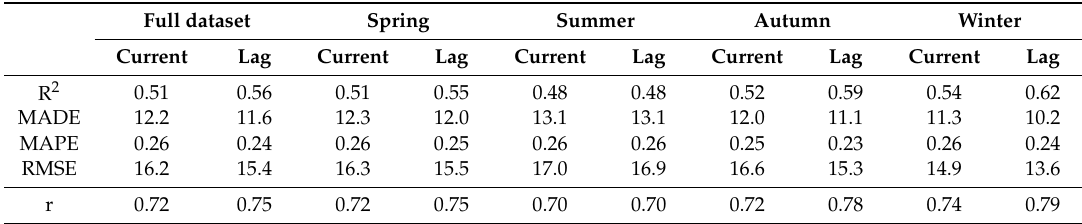
Table 4. Goodness of fit coe ffi cient for NO 2